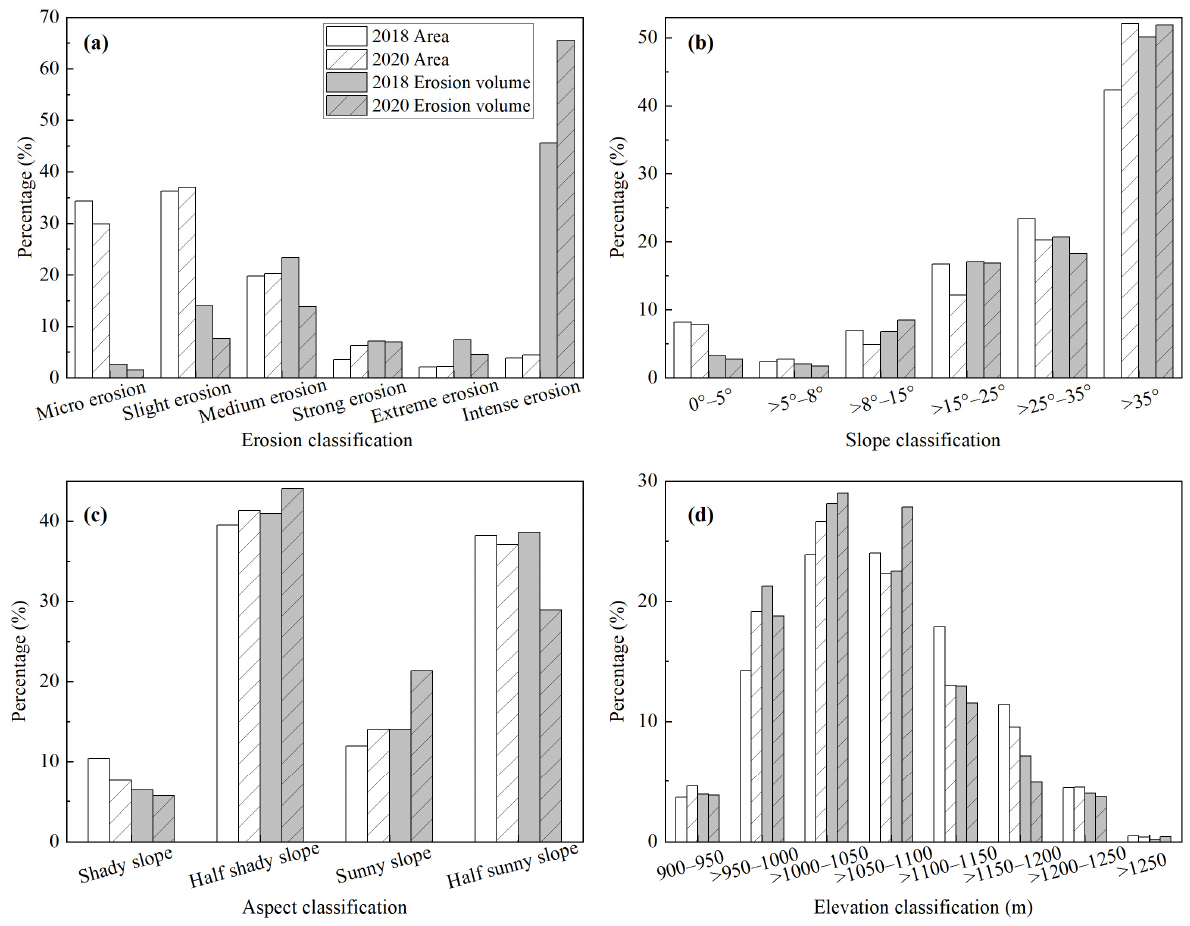
Figure 10. Comparison of soil erosion under different classifications. ( a ) Erosion classification; ( b ) slope classification; ( c ) aspect classification; ( d ) elevation classification.